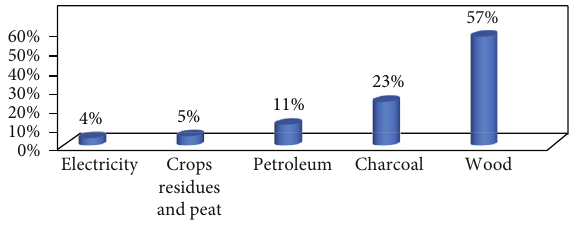
Figure 10: Main energy sources in Rwanda 2016